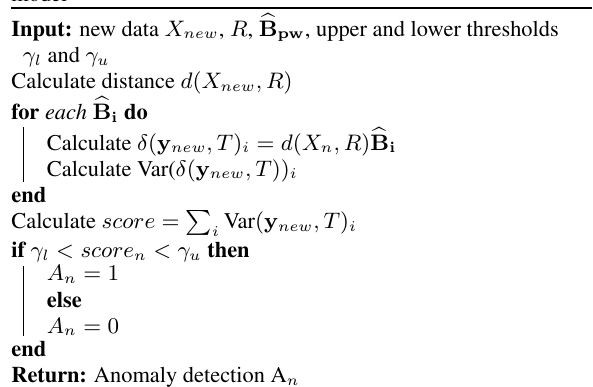
Algorithm 2: Anomaly detection using the piecewise MLM